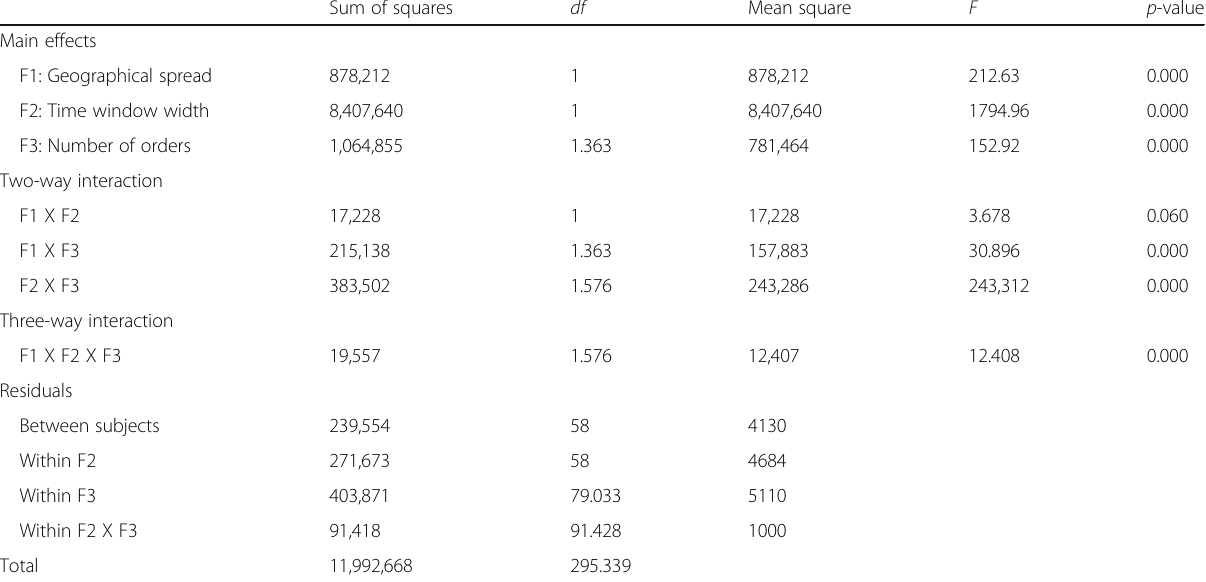
Table 4 Mixed model ANOVA results (design 2) Sum of squares df Mean